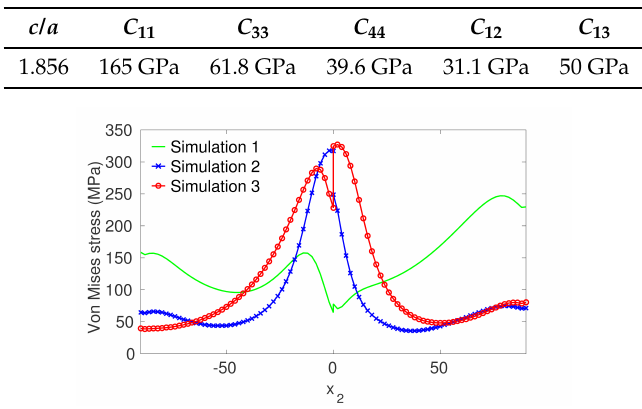
Table 7. Elastic parameters for Zn at ambient temperature [22].